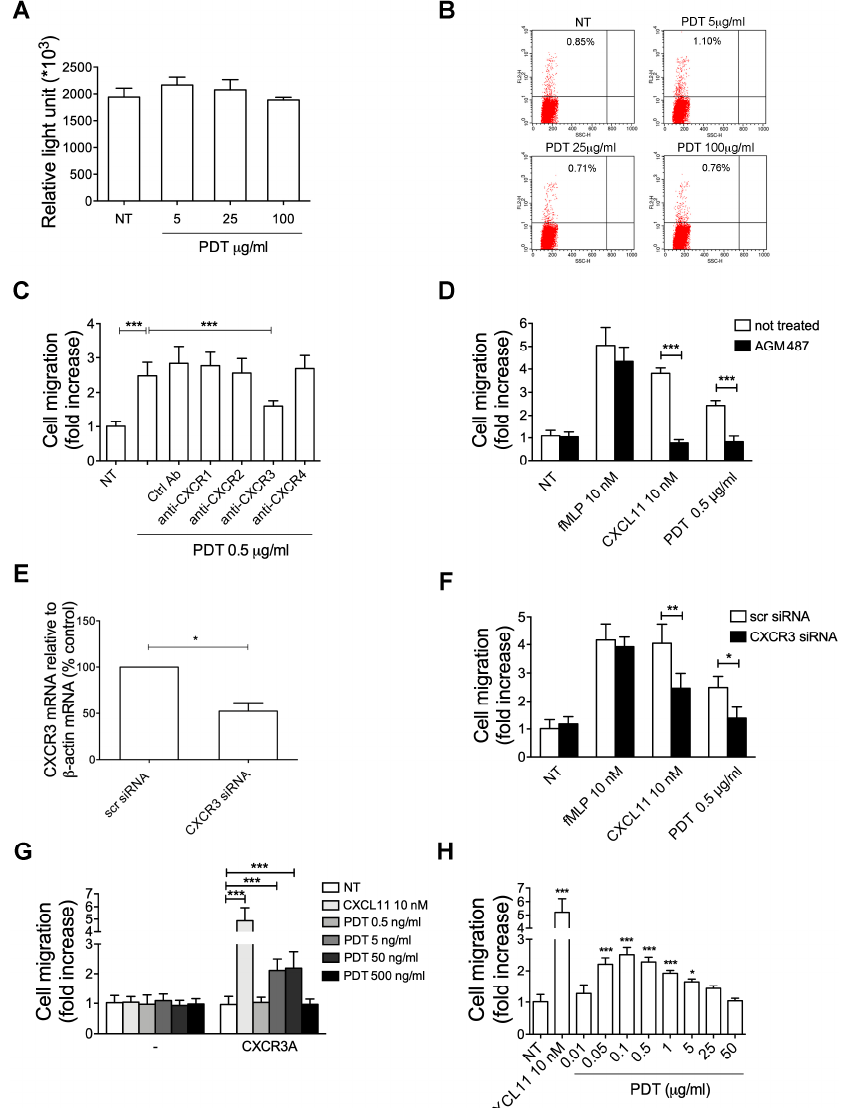
Figure 5. PDT–induced chemotactic activity is mediated by CXCR3. ( A ) Cells were treated or not (NT) with PDT (5, 25, 100 μ g/mL) for 2 h. Cell viability was assessed on 10 3 cells by CellTiter-Glo ® Luminescent Cell Viability Assay, based on determination of intracellular ATP concentration, according to manufacturer’s instructions. Bars represent the means ± SD of 3 independent